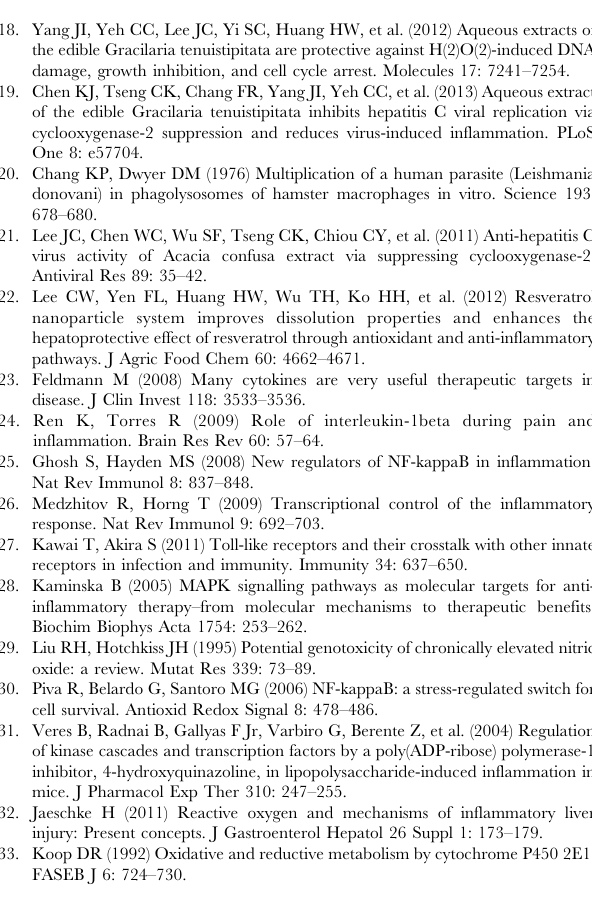
LPS alone. Error bars indicate the means 6 SD of three independent experiments. * P , 0.05; ** P , 0.01. (TIF) Figure S5 Effect of AEGT on CCl 4 -pre-induced acute liver inflammation in Wistar rat. The Wistar rats were administered CCl 4 for 1 day and then given the indicated doses of AEGT for 4 days. The rats were sacrificed to collect blood samples and liver sections for inflammatory parameter analysis of secreted protein levels of proinflammatory cytokines including TNF- a (A), IL1- b (B) and IL-6 (C), and biochemical parameter analysis of AST (D) and ALT (E) and histopathological examination [Healthy control (F), CCl 4 with saline (G), CCl 4 with 150 mg/kg/day AEGT (H), and CCl 4 with 300 mg/kg/day AEGT (I)]. Values are presented as the means of five independent experiments. Error bars indicate the means 6 SD of three independent experiments. * P , 0.05; ** P , 0.01.